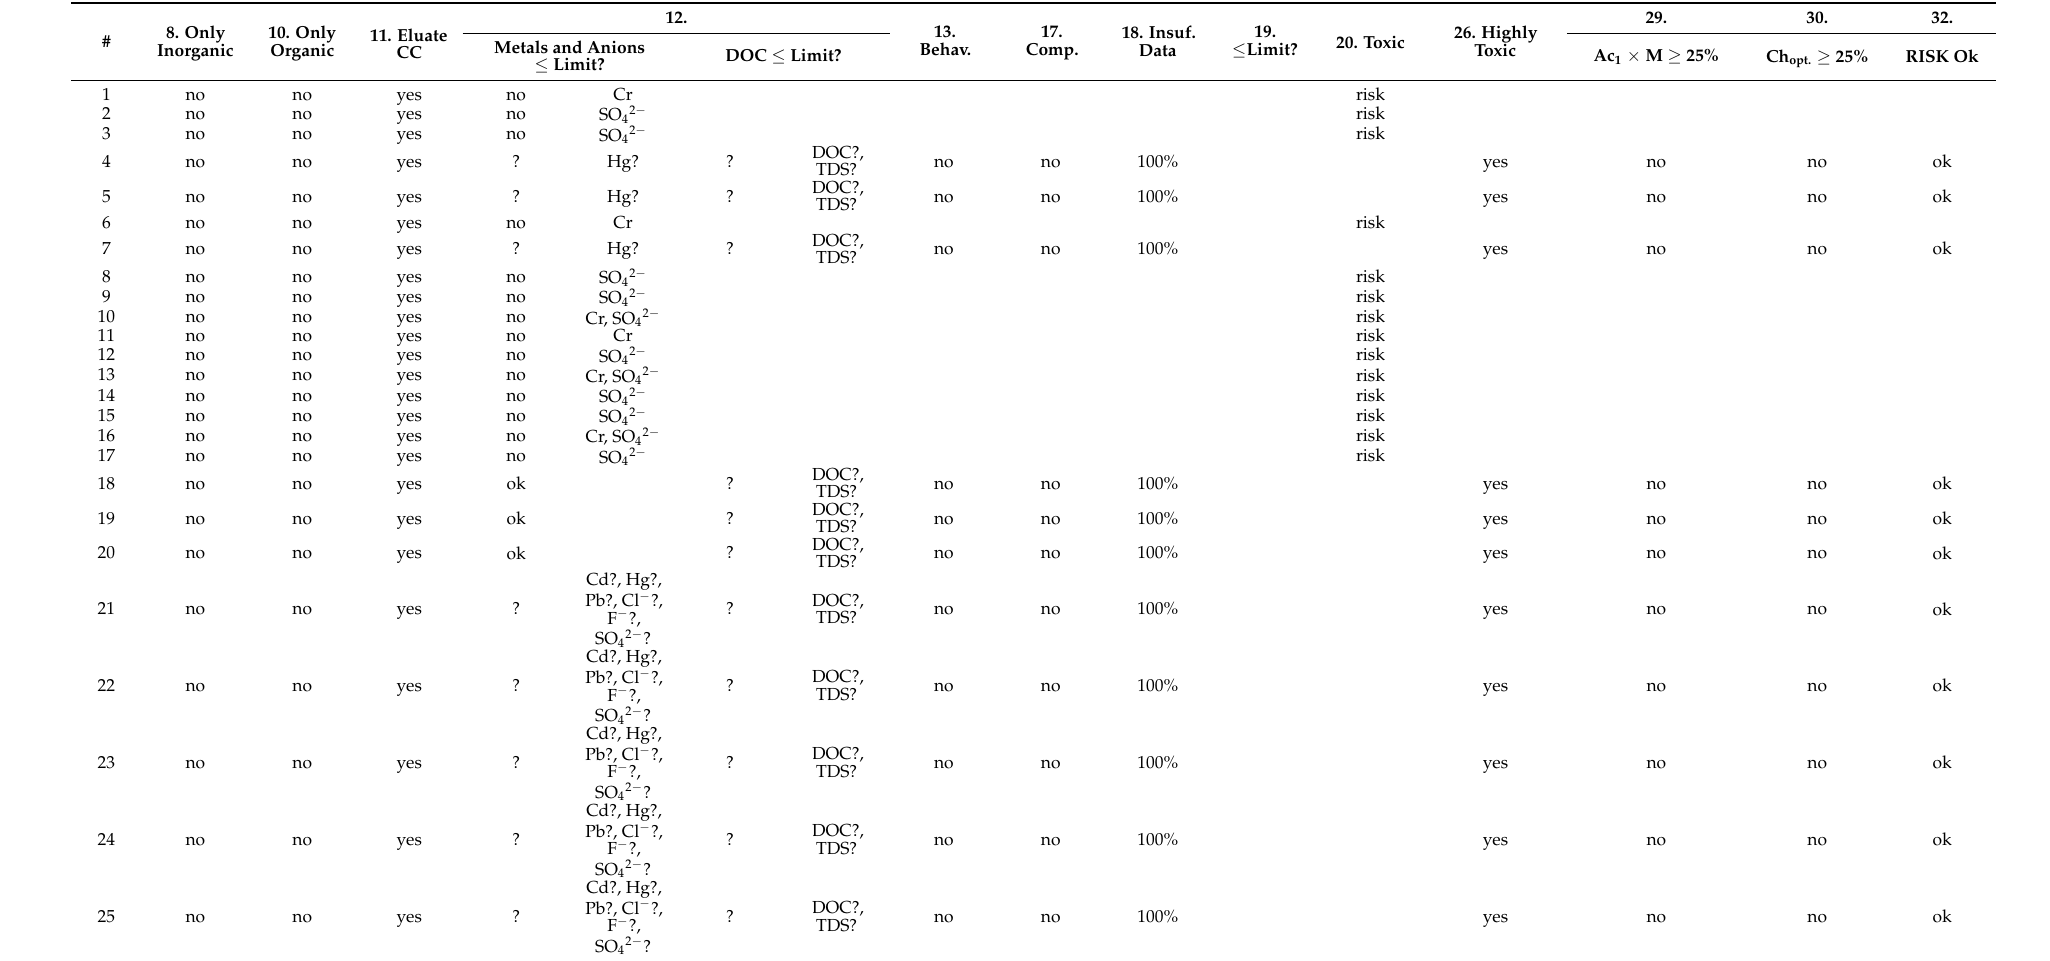
Table A3. Methodology step results for individual RAs’